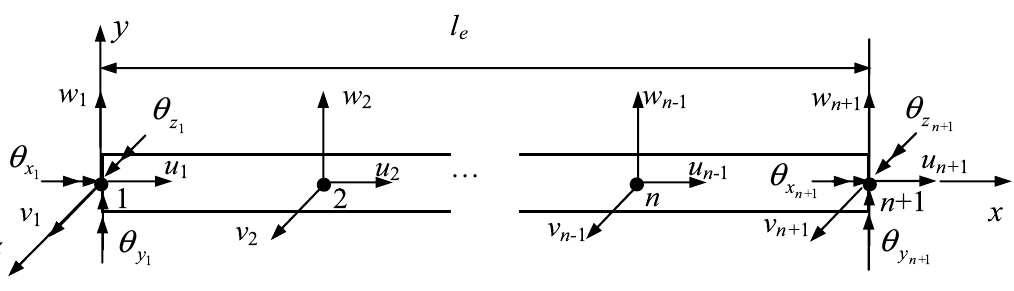
Fig. 1. The layout of element nodes and the corresponding DOFs for wavelet-based